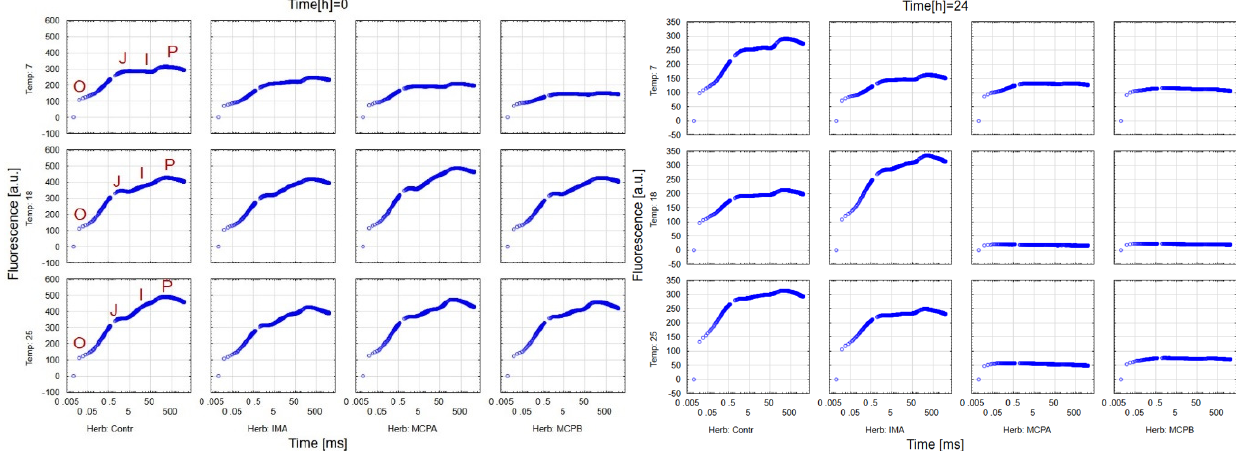
Figure 7. Fast chlorophyll fluorescence kinetics (OJIP) in absolute values recorded before the application of herbicides ( left panel ) in the plants exposed for 24 h to MCPA, MCPB and IMA ( right panel ). The OJIP curves are means of five replicates and presented for the plants of G. orientalis cultivated at three different temperatures (7, 18 and 25 °C in the upper, middle and lower rows). Note the herbicide-induced “flattening” of the OJIP curves in MCPA- and MCPB-treated plants after 24 h exposure.